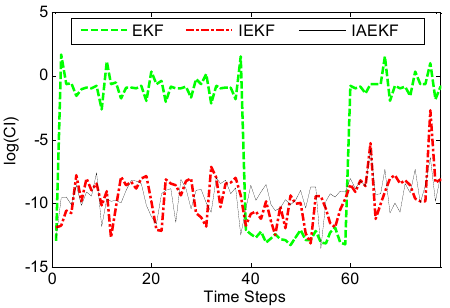
Figure 6. Values of convergence indices (CIs) for CFE by EKF-based approaches.